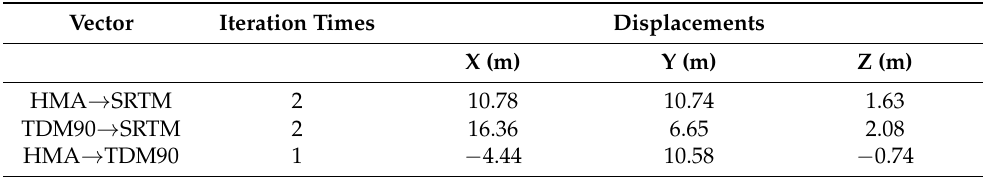
Table 1. Parameters of DEM